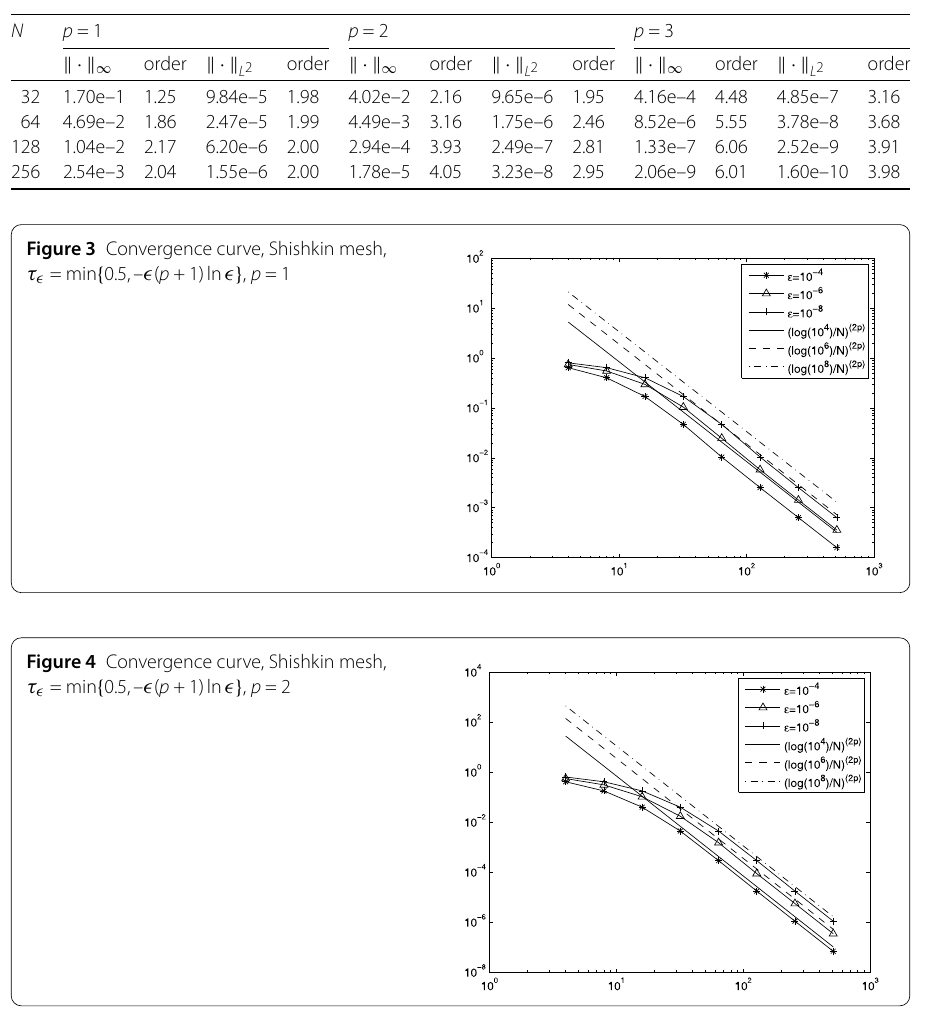
Table 4 Shishkin mesh, τ (cid:2) = min { 0.5,– (cid:2) ( p + 1)ln (cid:2) } , (cid:2) = 10 –8